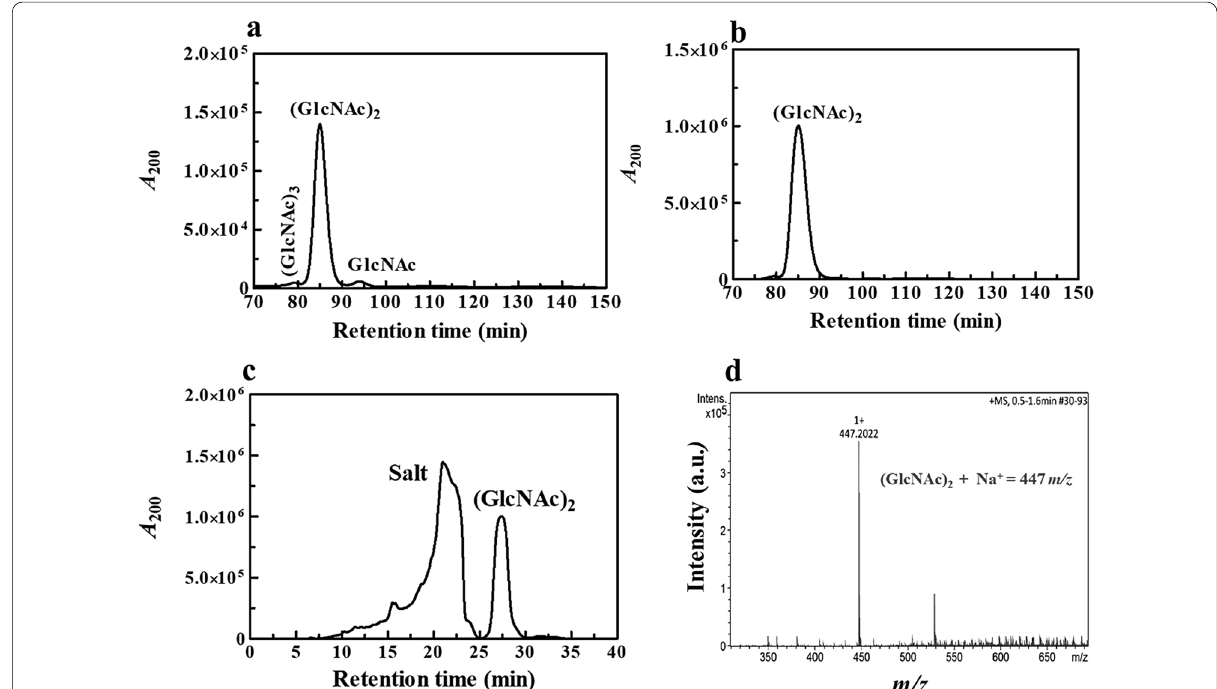
Fig. 5 Purification of (GlcNAc) 2 product. a Reaction sample before passage through a gel filtration column packed with cellulose beads (Cellufine, lot No. R2407, JNC Corporation, Japan) column. b Reaction sample after gel filtration. Sugar products were detected at 200 nm. DP1, DP2, and DP3 represent GlcNAc, (GlcNAc) 2 and (GlcNAc) 3 , respectively. c (GlcNAc) 2 was eluted from a preparative NH 2 P-50 10E column, by acetonitrile water mixture (70:30 v/v ) and detected in a PDA mode 200 nm. The retention time of the product was compared with those of standard sugars (data not shown). d Product characterization of chitobiose by QTOF-MS